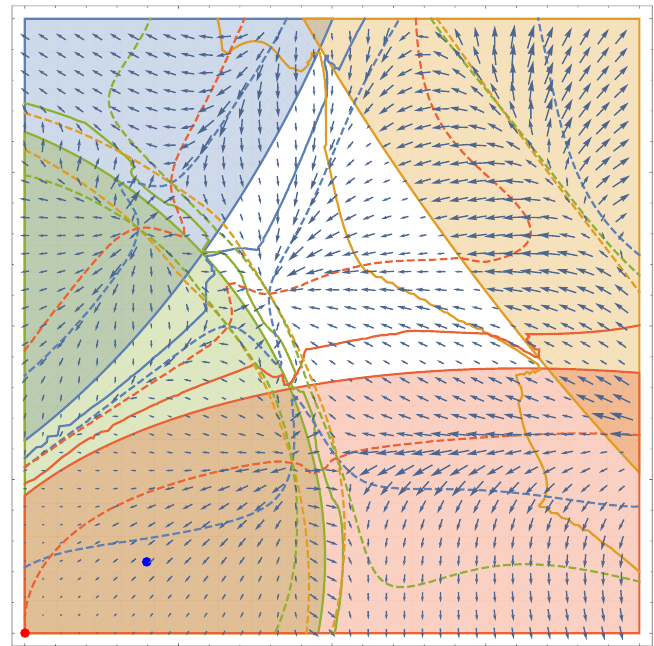
Figure 10. A zoom-in on the centre region between the E-surfaces (cid:17) (shaded) of Box4E : the deformation vector (cid:12)eld ~(cid:20) (blue arrows) as well as the solutions to Re (cid:17) = 0 (solid) and Im (cid:17) = 0 (dashed) show the complicated interplay between direction, magnitude and displacement of the surfaces in complex space. The deformation vector ~(cid:20) vanishes on the focal point